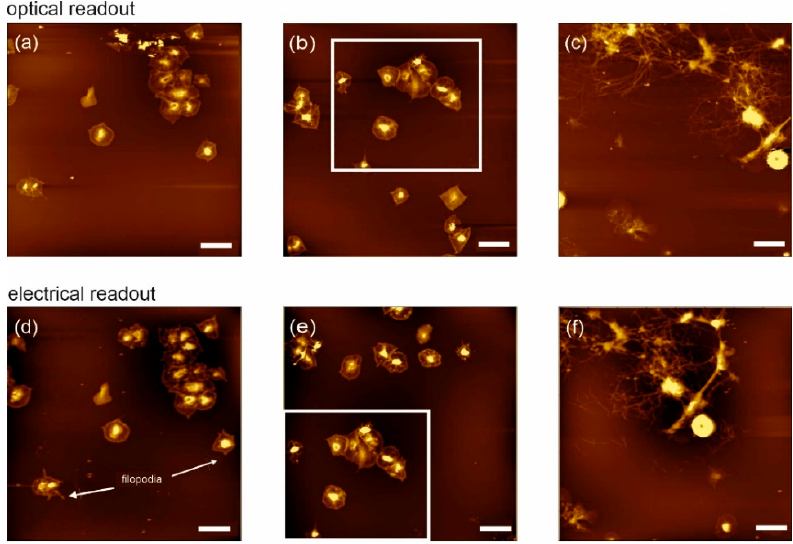
Figure 2. Comparison of optical and electrical readout on physiologically relevant samples in air: The upper part shows platelets after one ( a ), three ( b ) and five minutes ( c ) incubation, imaged with optical cantilevers and magnetic excitation. In comparison, the same sample positions were imaged with self-sensing cantilevers ( d – f ), yielding equal results (lower part). The scale bar is 10 µ m for all images. Z-scale: ( a , d ): 191 nm, ( b , e ): 200 nm, ( c , f ): 900 nm.